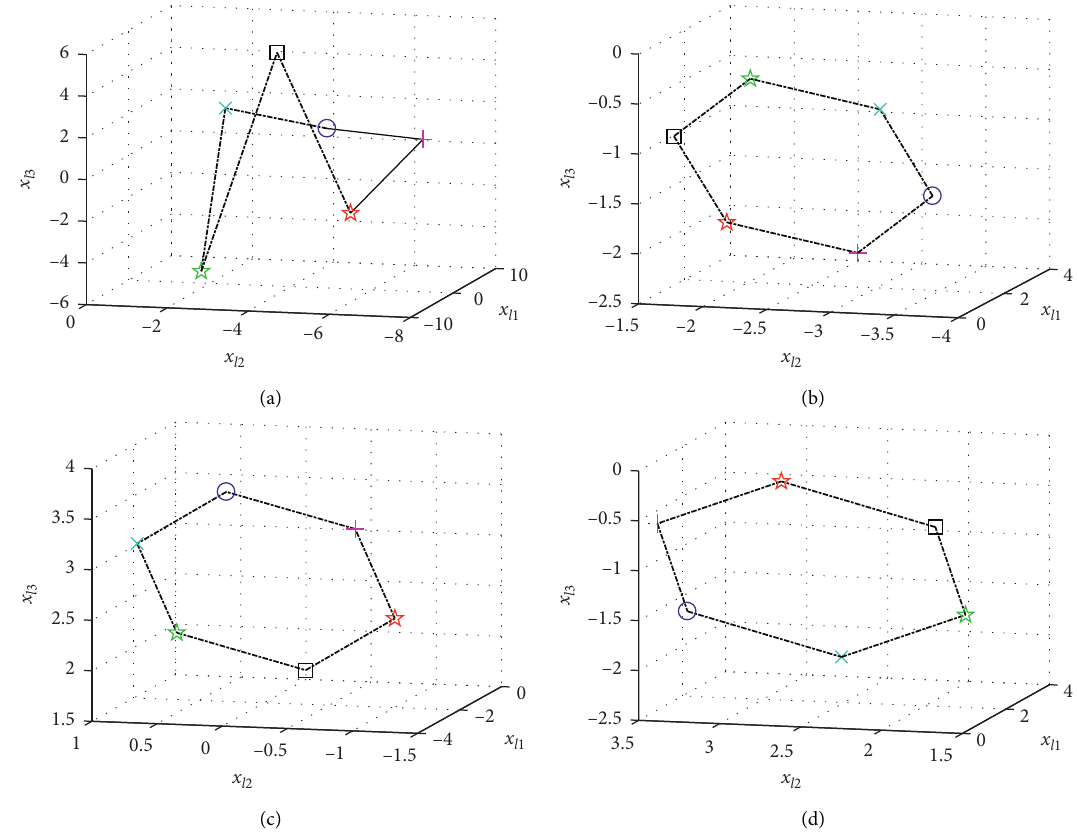
Figure 3: State snapshots of six agents at different times: (a) t � 0s; (b) t � 8 s; (c) t � 9s; (d) t �